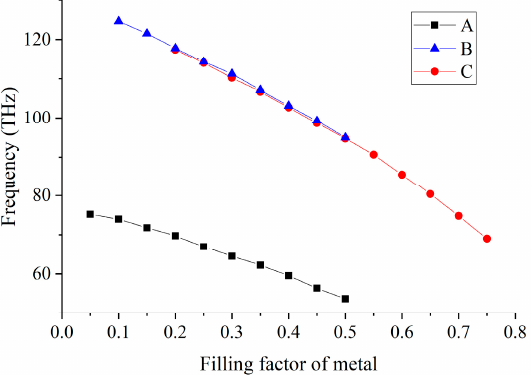
Figure 5. The frequencies of the SC points A (black), B (blue) and C (red) as functions of the filling factor (of metal) of the HMM.